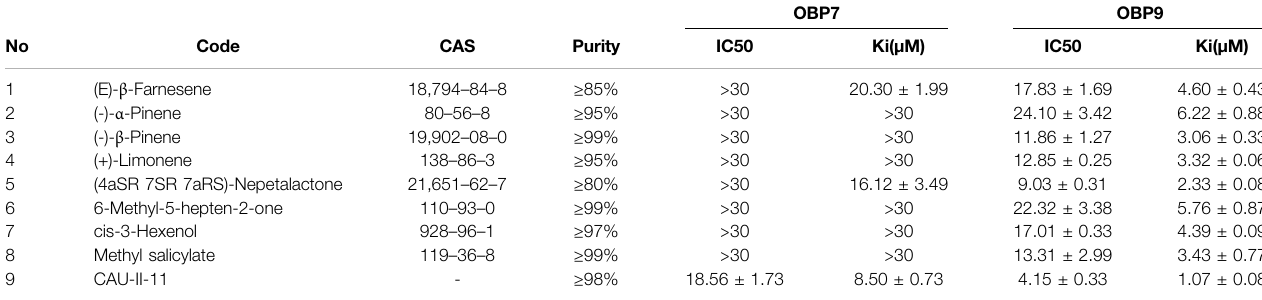
TABLE 1 | Binding af fi nities of AgifOBP7 and AgifOBP9 for candidate ligands, evaluated in displacement binding assays using the fl uorescent probe, 1-NPN.